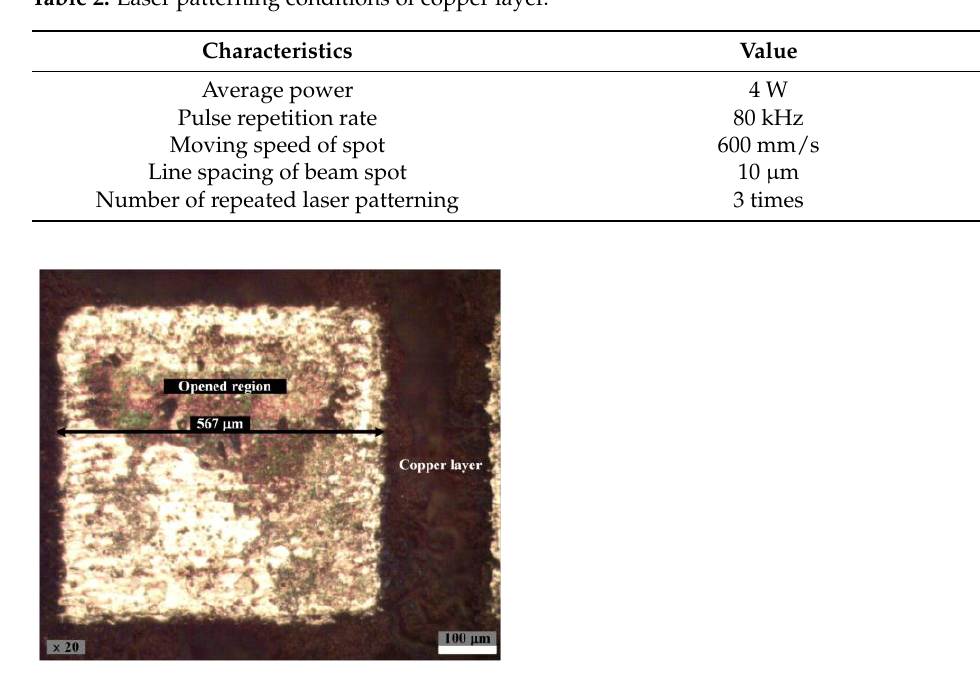
Table 2. Laser patterning conditions of copper layer.